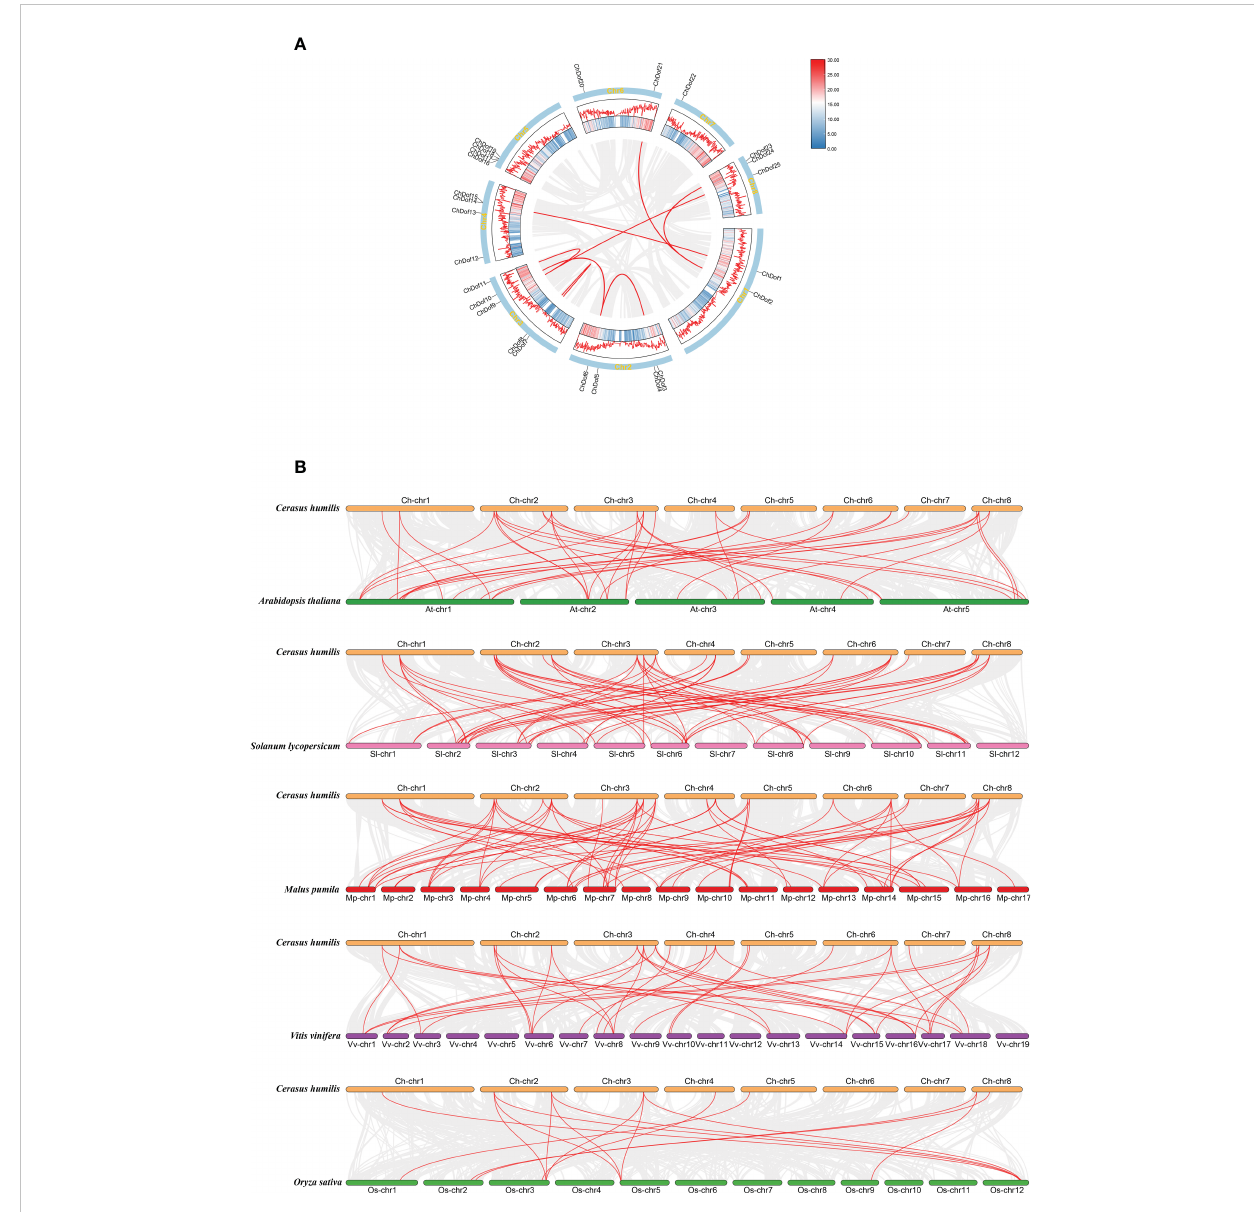
FIGURE 5 Chromosomal locations and Synthetic analysis. (A) Chromosomal locations and segmental duplication events of 25 ChDof genes. Red lines represent segmental duplication events. (B) Synthetic analysis of Dof genes in C. humilis , Arabidopsis thaliana , Solanum lycopersium , Malus pumila , Vitis vinifera and Oryza sativa genomes. The red lines represent homologous gene pairs between two adjacent